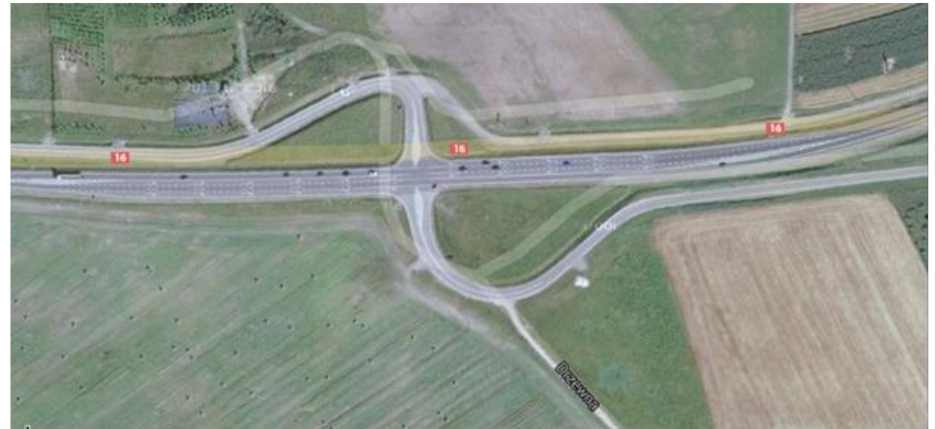
Figure 3. Estimated location of solar panels on national road No. 16 (Gietrzwałd). Source: [61].